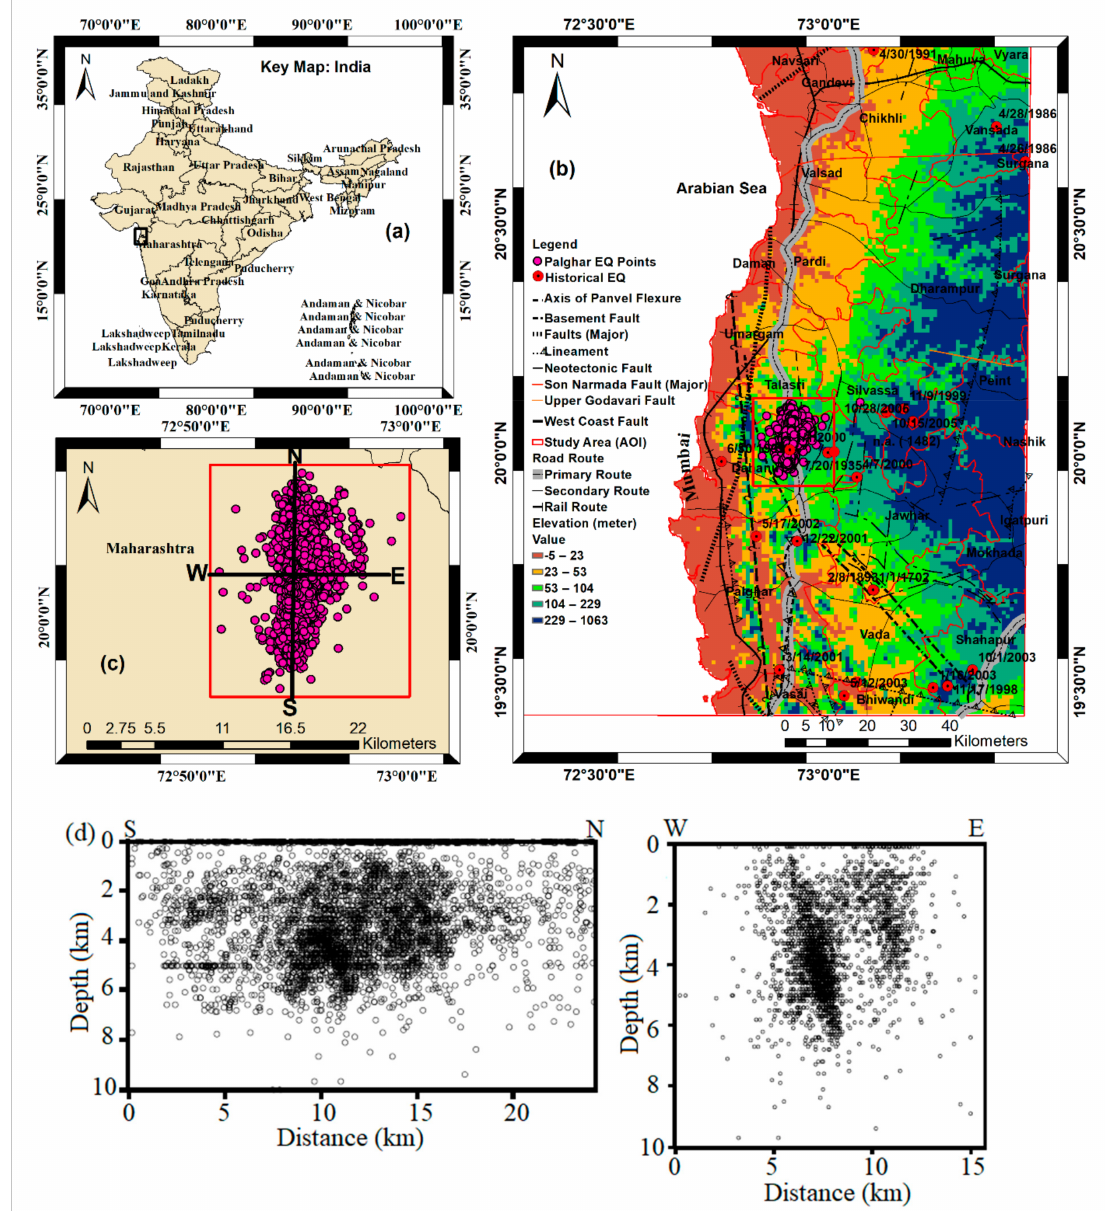
Figure 1. ( a ) Location map of the study area; ( b ) shows entire study area (broad regions) with digital elevation model (DEM) map and with recently observed earthquake swarms shown with solid magenta color (small area with red bounding box) and historical earthquakes (red color dot) data; ( c ) earthquakes swarms in zoom view with two transect lines North-South (N-S) and East-West (E-W) and ( d ) shows depth distribution of earthquakes along N-S (left panel) and E-W (right